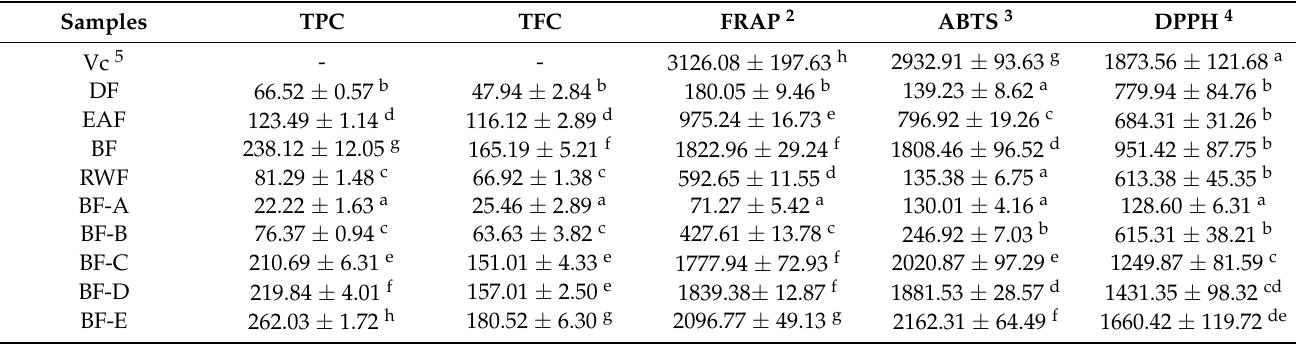
Table 1. TPC, TFC, and antioxidant capacity values of four fractions and five subfractions from Anneslea fragrans Wall 1